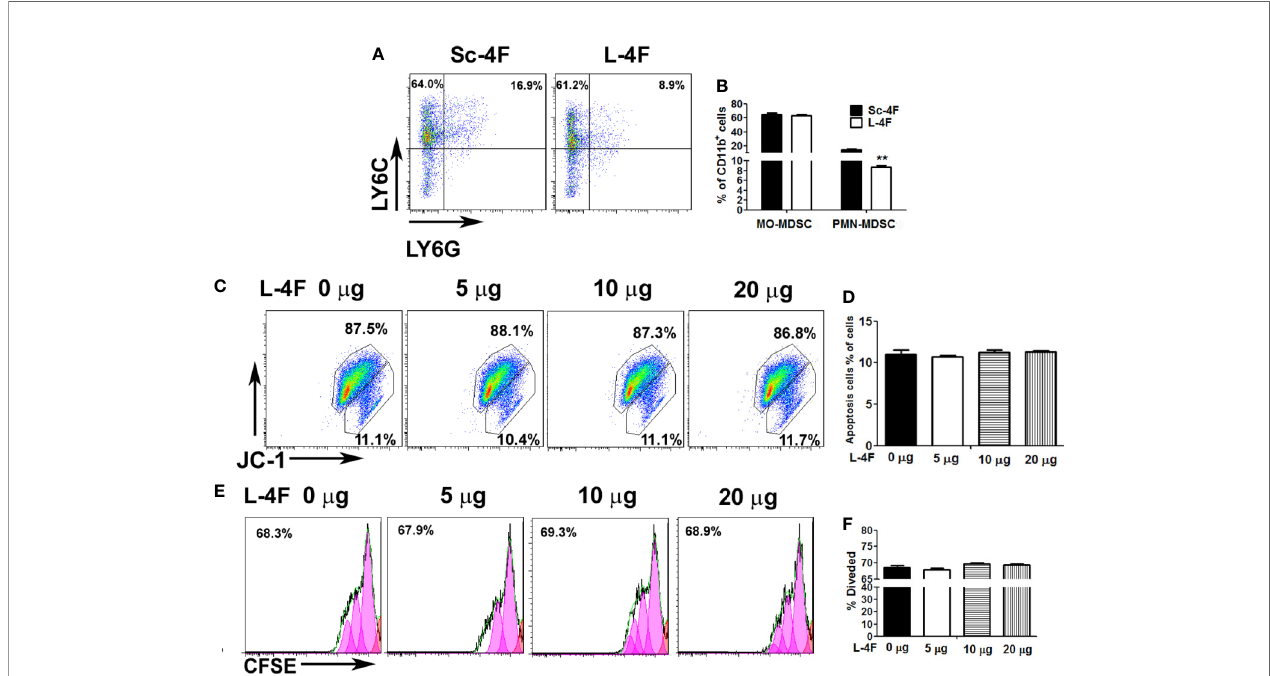
FIGURE 2 | The effect of L-4F on MDSCs differentiation, proliferation and apoptosis. Bone marrow cells were treated with Sc-4F/L-4F (20 m g/ml) on day 0 of the MDSC induction. (A) One representative result from each experiment. (B) The percentages of MO-MDSCs and PMN-MDSCs among the induced cells (**P < 0.01). (C, E) MDSCs were treated with L-4F (0, 5, 10, or 20 m g/ml). One representative result from each experiment is shown. (D) The percentage of apoptotic cells and (F) the percentage of divided cells treated with L-4F at 48